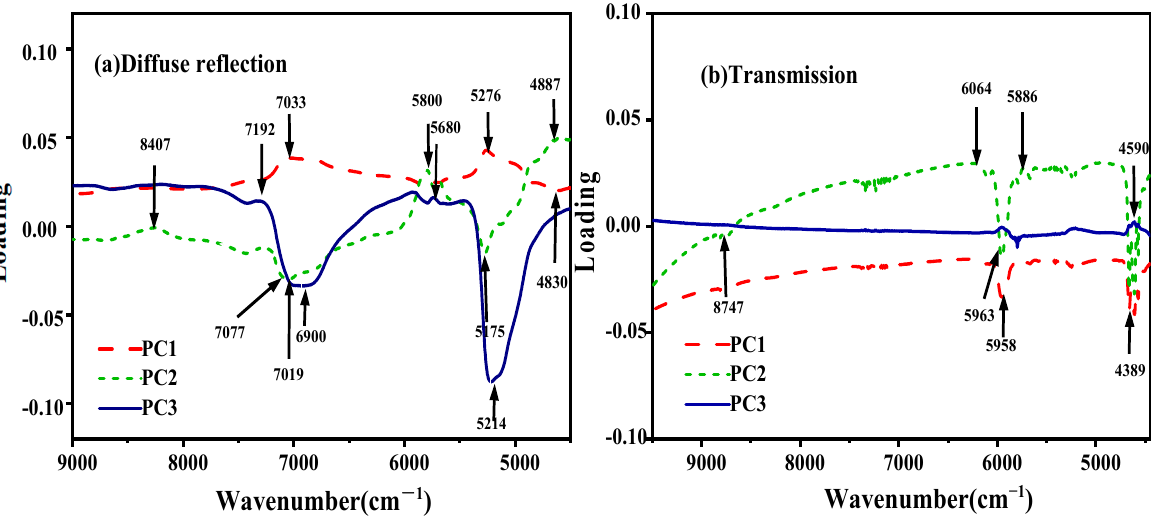
Figure 5. PCA score loading diagram of the sample.